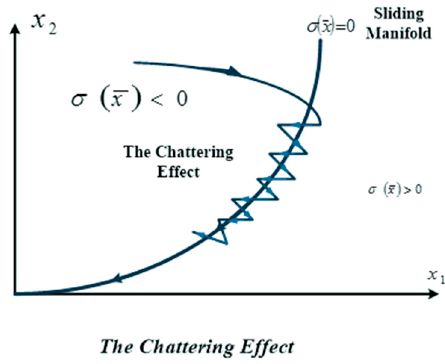
Figure 7. The chattering effect of Sliding Mode Controller (SMC).